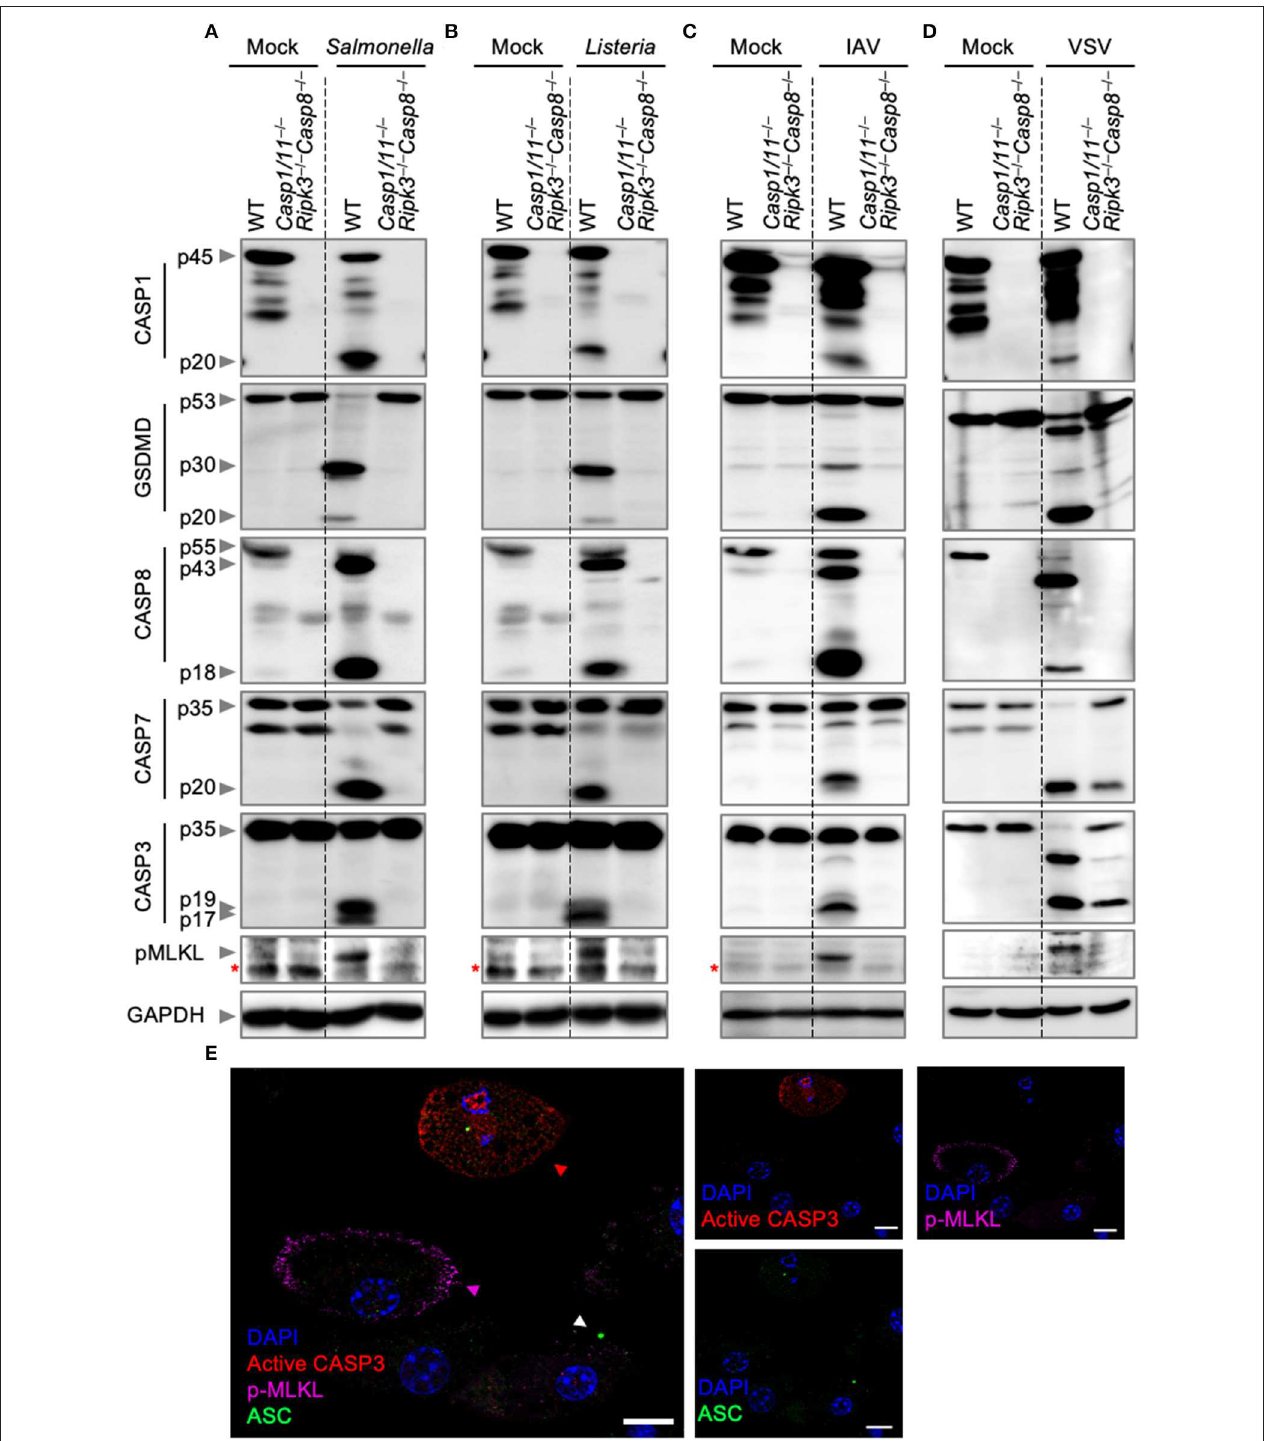
FIGURE 2 | Bacterial and viral infections activate PANoptosis in vitro . Western blot analysis of PANoptosis activation markers after (A) S . Typhimurium, (B) L. monocytogenes, (C) IAV, and (D) VSV infection. Activation of pyroptosis was measured by immunoblotting of cleaved CASP1 (p20) and activated GSDMD (p20/p30). Activation of apoptosis was measured by immunoblotting of active CASP8 (p18), active CASP7 (p20), and active CASP3 (p17/19). Activation of necroptosis was measured by phosphorylation of MLKL (pMLKL). Red asterisks denote a non-specific band. (E) Confocal imaging of PANoptosis activation in wild-type BMDMs following S . Typhimurium infection. ASC speck formation (white triangle), cleavage of CASP3 (red triangle), and pMLKL localization to the membrane (purple triangle) were used as readouts of PANoptosis. Scale bar, 10 µ m.